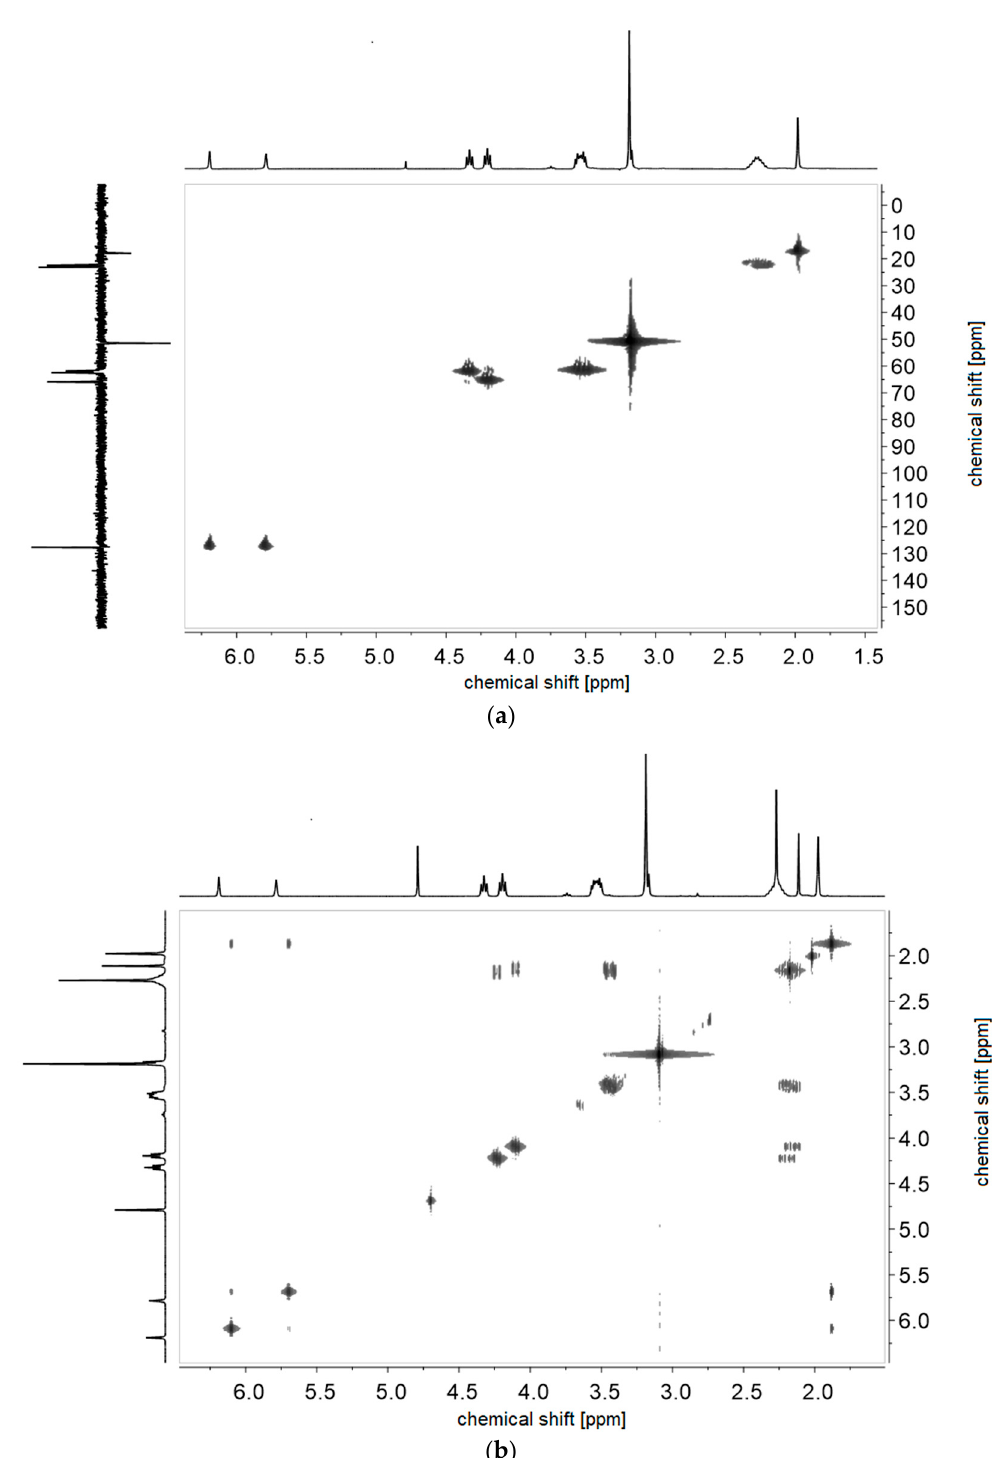
Figure A4. ( a ) 1 H- 1 H-COSY- and ( b ) 1 H- 13 C-HMQC NMR-spectra of monomer of 2d in D 2 O.